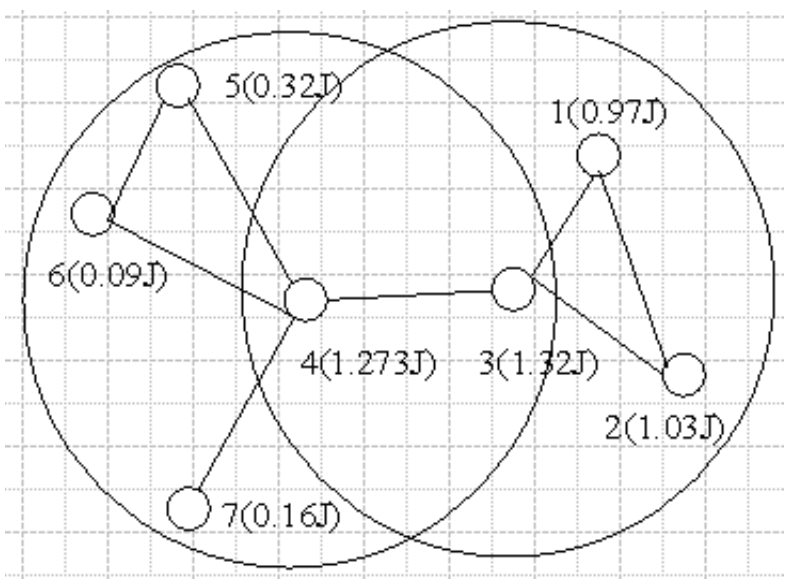
Figure 1. Example for cluster head